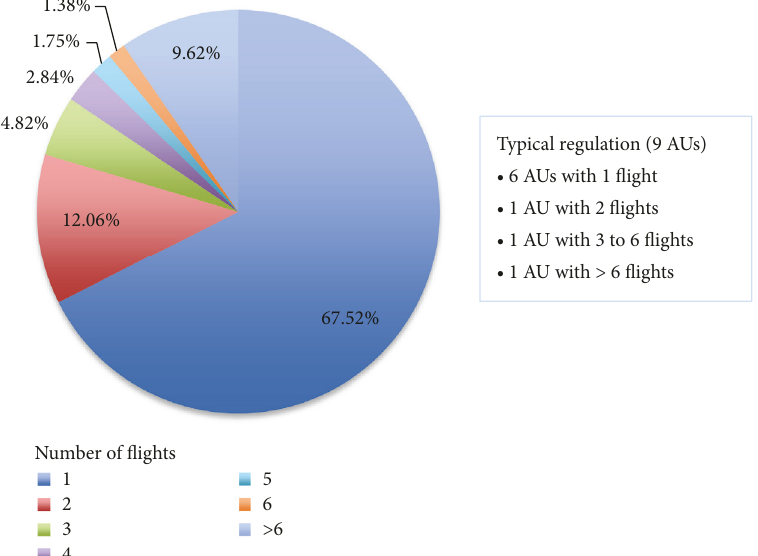
Figure 2: Statistically typical regulation/hotspot in terms of number of AUs and number of flights per AU.